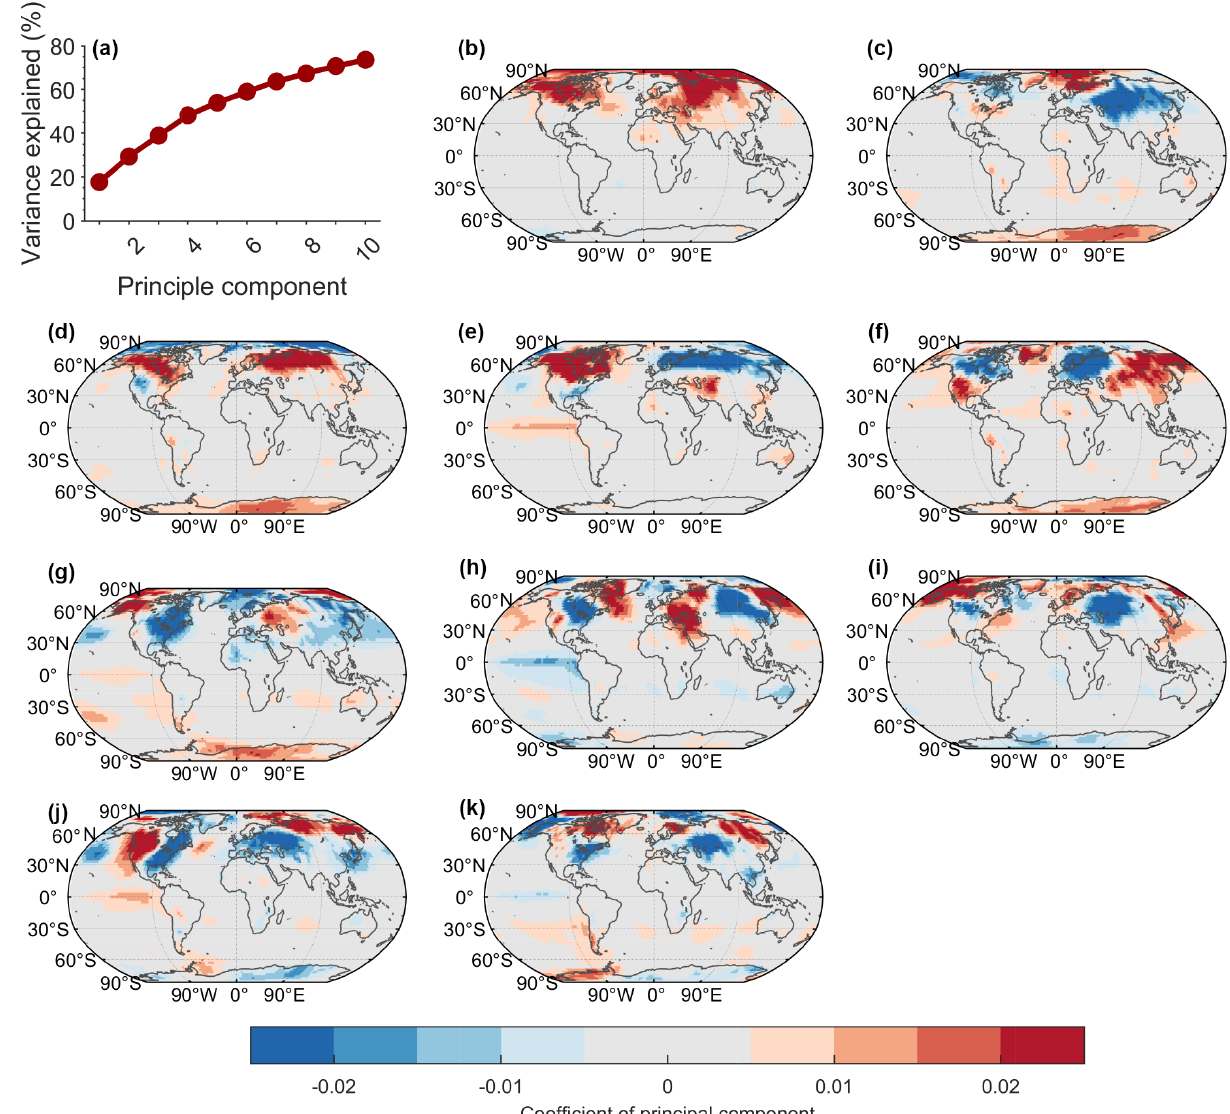
Figure 2. The corresponding results from the PCA of the gridded temperature in January between 1901 and 1950 from GSWP3: (a) the cu- mulative variance explanation rate of the top 10 principal components; (b–k) coefficients of the top 10 principal components (corresponding to U Spatial e,m ( : ,i) , i =